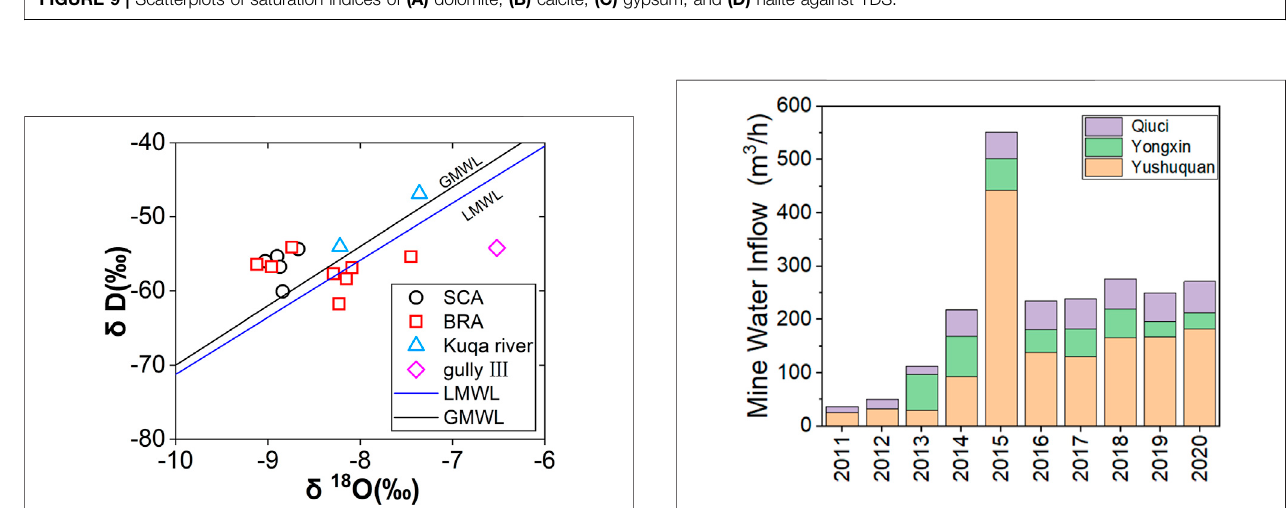
FIGURE 9 | Scatterplots of saturation indices of (A) dolomite, (B) calcite, (C) gypsum, and (D) halite against TDS.